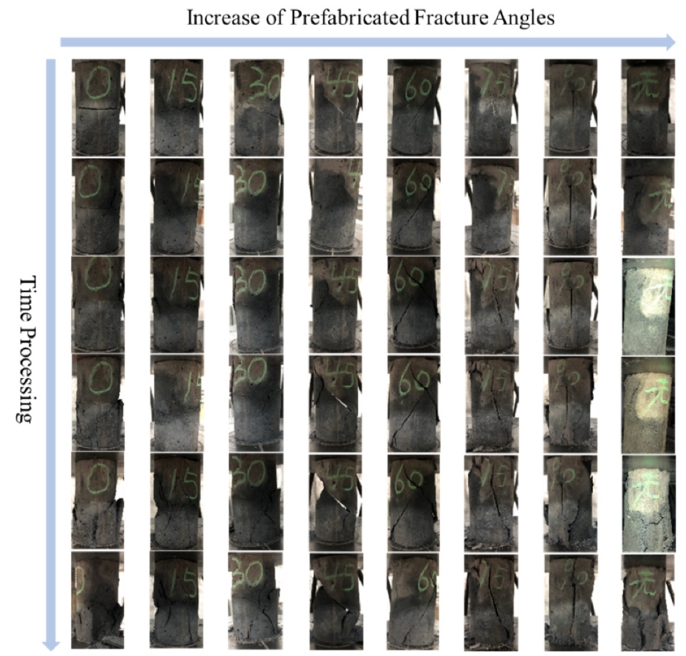
Figure 4. Failure processes and characteristics of specimens.